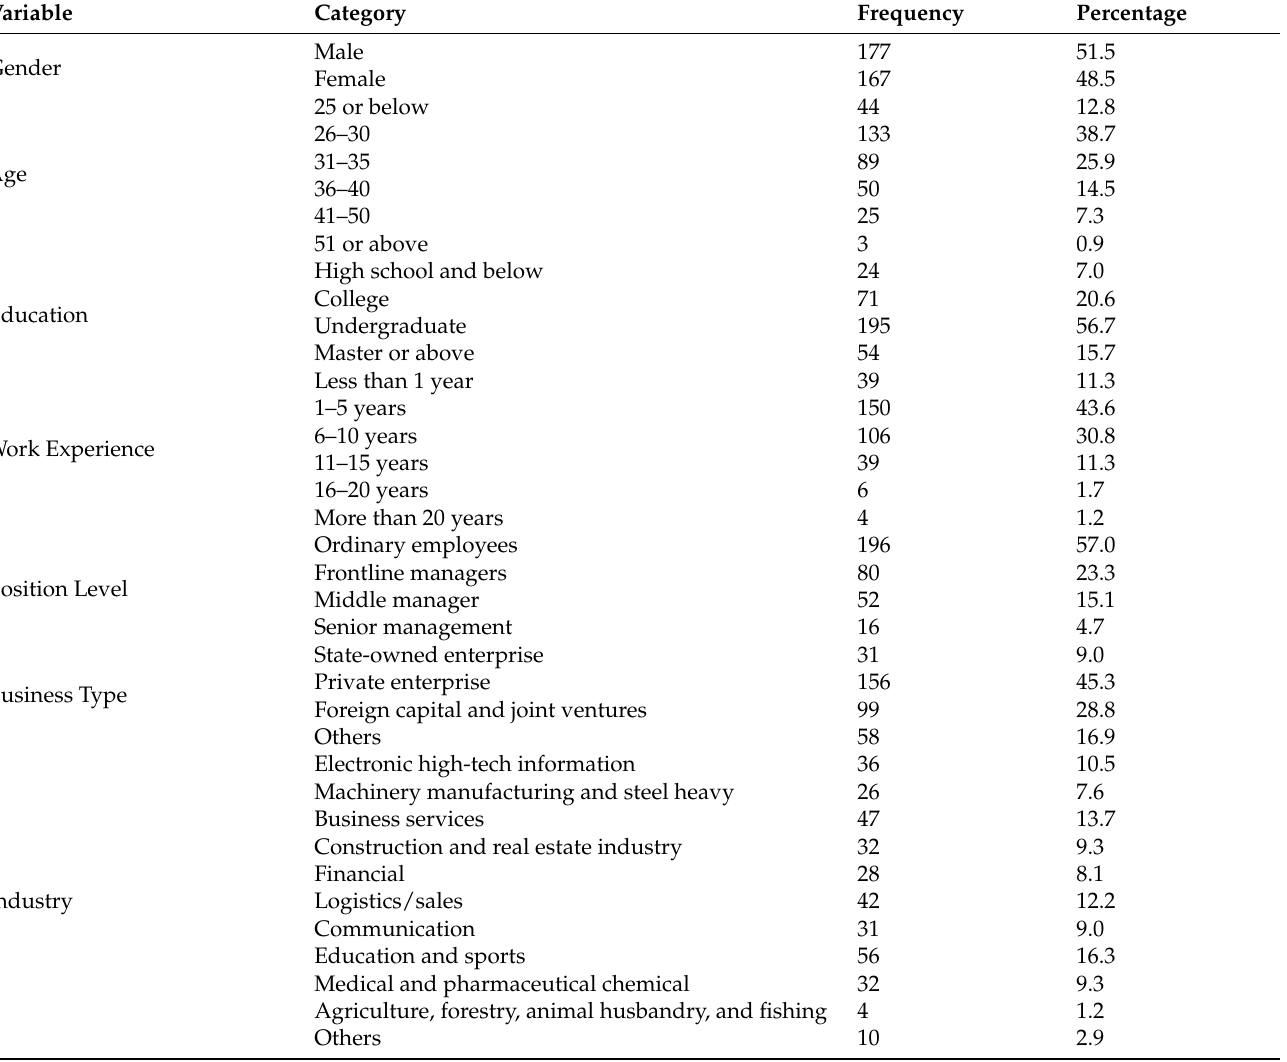
Table 2. Demographic statistics of the sample (N =